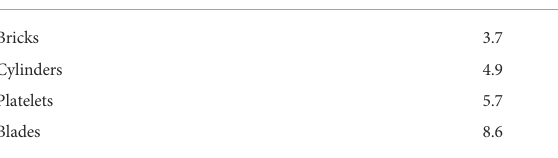
TABLE 4 Attributes for different shape